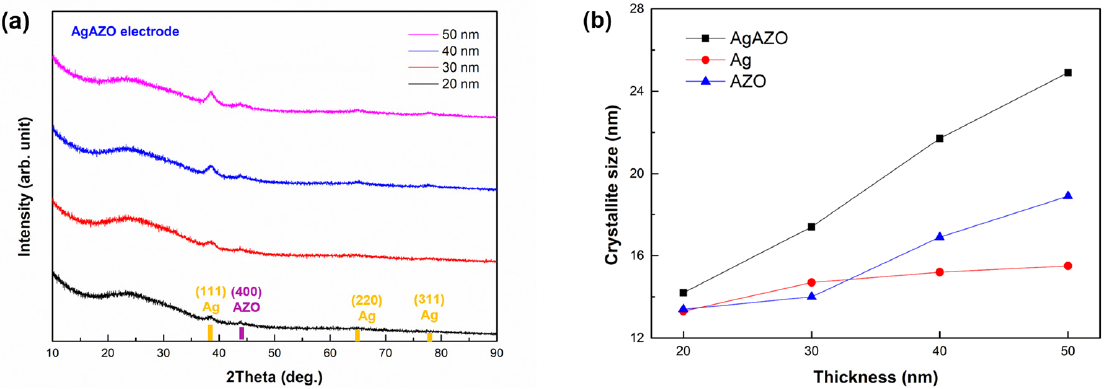
Figure 2. Structural characteristics of Ag:AZO thin film depending on thickness. ( a ) XRD measure- ment results. ( b ) Crystallite size according to the thickness of the electrodes.